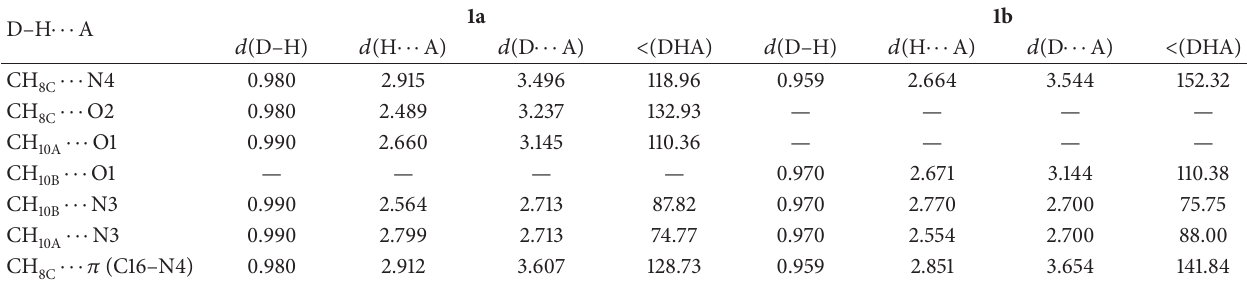
Figure 2: Packing diagram of 1st and 2nd polymorph along 𝑏 -axis. Table 2: Intramolecular hydrogen: bonding geometry (˚A and deg) for 1a and 1b